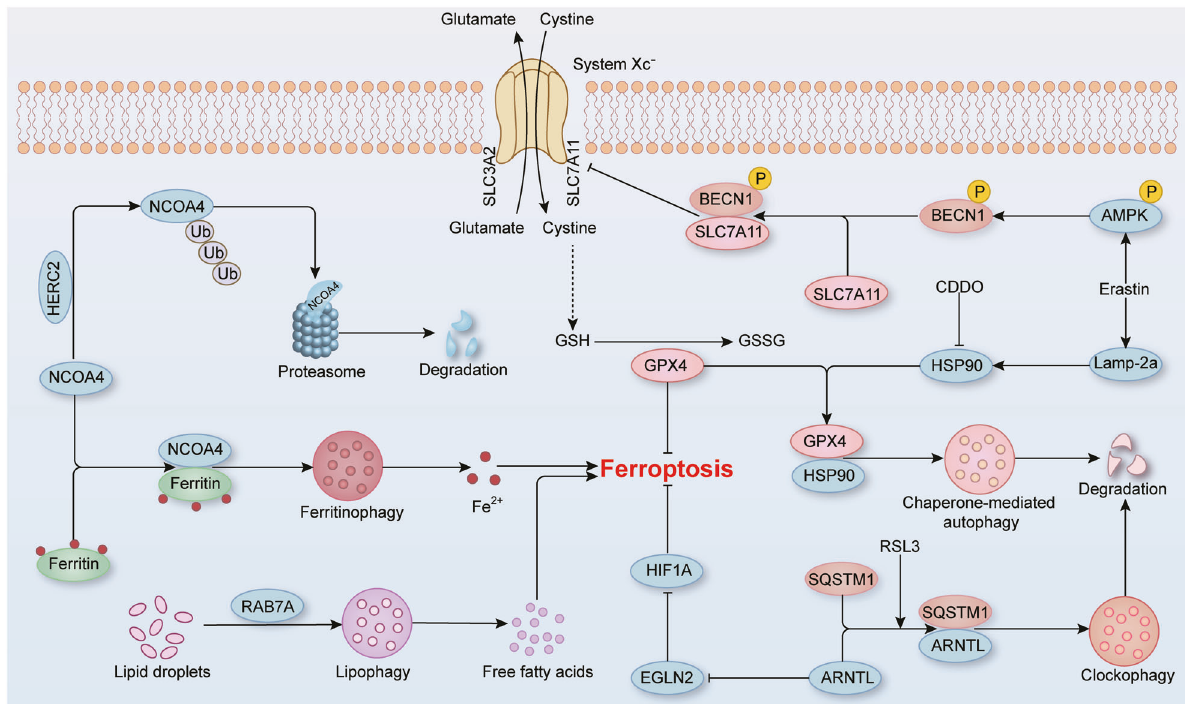
Fig. 2 Ferroptosis is a type of autophagy-dependent cell death. NCOA4-mediated ferritinophagy induces ferritin degradation and iron overload, fi nally promoting oxidative injury and ferroptosis. E3 ubiquitin ligase HERC2 drives the proteasomal degradation of NCOA4 and enhances the stabilization of ferritin, which decreases intracellular levels of iron. RAB7A-mediated lipophagy and SQSTM1-mediated clockophagy both contributes to lipid peroxidation in ferroptosis. Erastin not only increases the expression of Lamp-2a, which promotes HSP90-mediated chaperone-mediated autophagy to degrade GPX4, but also promotes the combination of BECN1 and SLC7A11 to block System Xc- activity via AMPK phosphorylation.